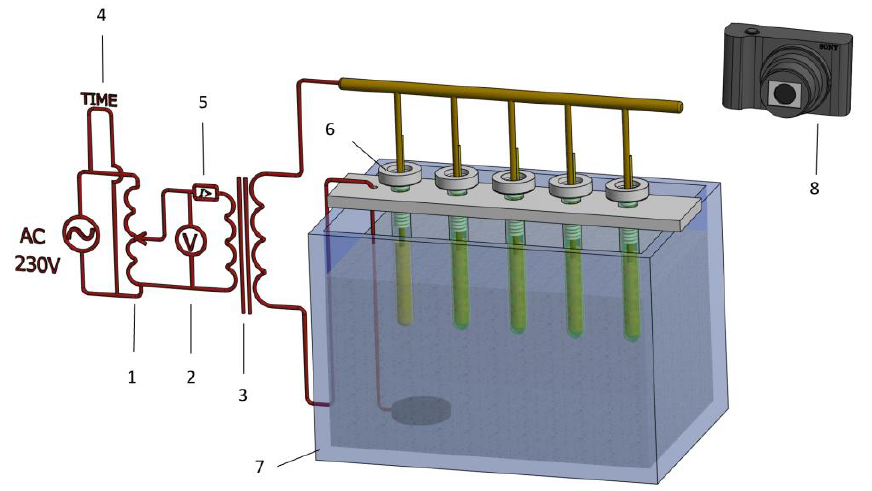
Figure 2. Experimental setup: 1 — adjustable transformer for setting the voltage value, 2 — voltmeter, 3 — high voltage transformer, 4 — timer, 5 — current relay, 6 — aging cell, 7 — glass tank, and 8 — video recorder camera.